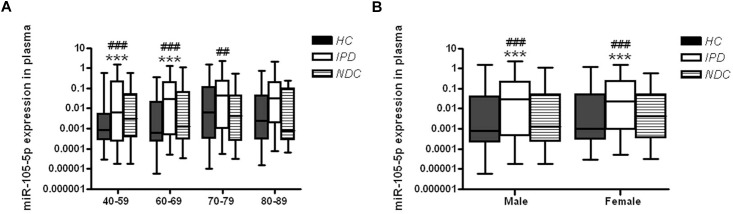
Plasma miR-105-5p expression levels in IPD patients and controls concerning the (A) age and (B) gender effects. Whiskers in the box plots represent minimum to maximum value. The center line in the box represents the median value. Non-parametric ANOVA test. ∗∗∗P< 0.001 vs. HC, ##P< 0.01 vs. NDC, ###P< 0.001 vs. NDC.